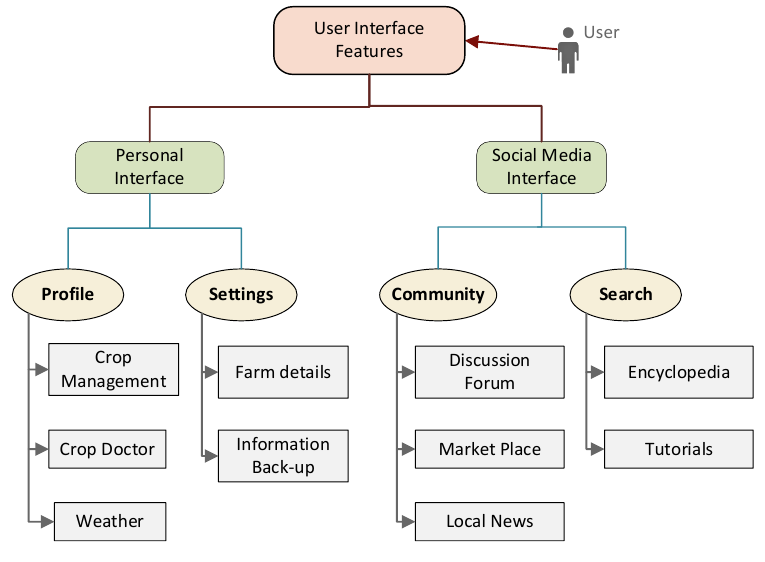
Figure 4: Homepage sections and features of